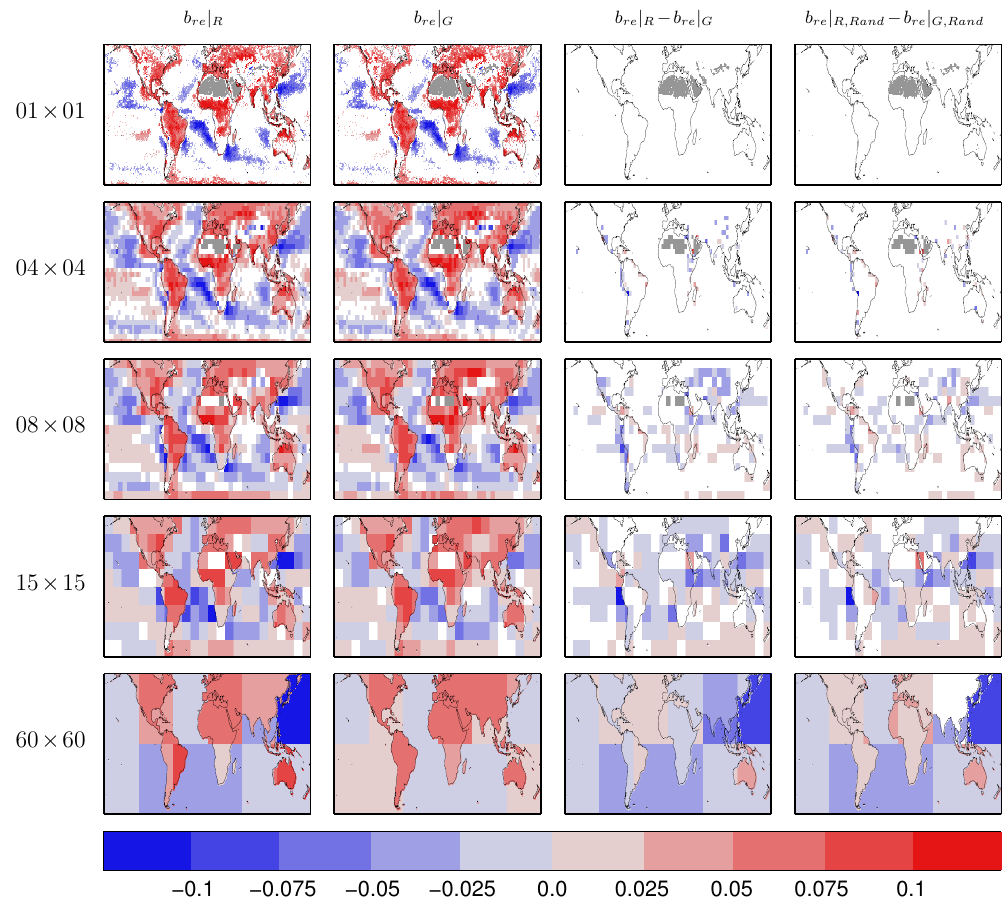
Fig. 5. Same as Fig. 3, but for sensitivity of r e to τ a . Fig. 4. Same as Fig. 2, but for sensitivity of r e to τ a